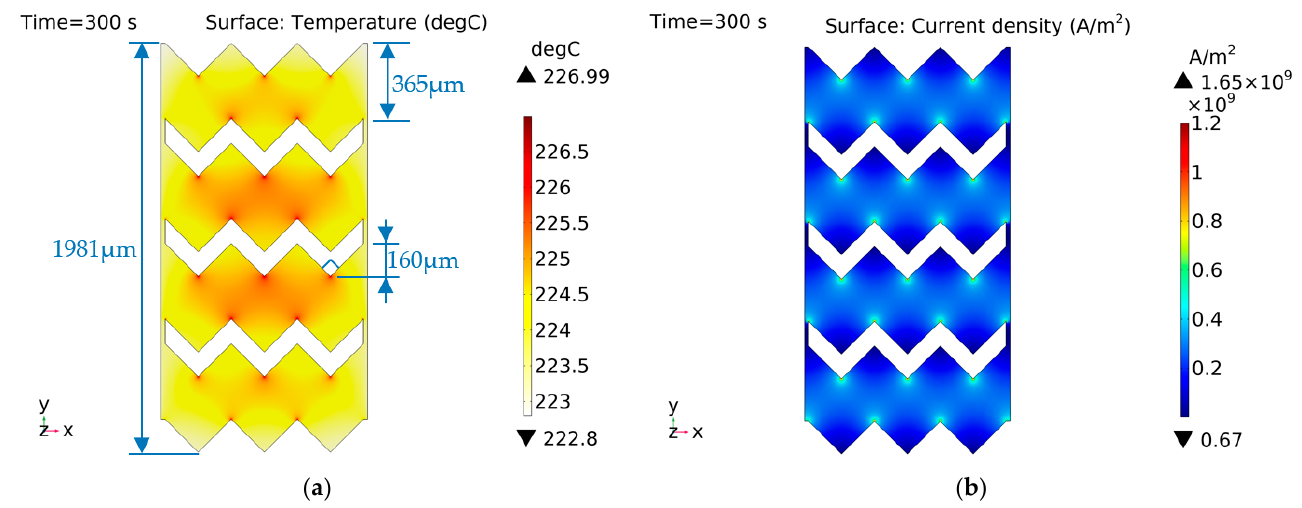
Figure 18. Characteristic distribution of shape D with a constant current (1 A) excitation. ( a ) Temperature distribution; ( b ) current density distribution.